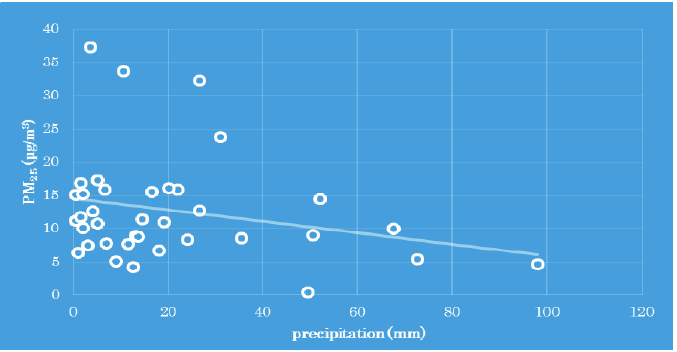
Figure 7. The relationship between PM 2.5 and precipitation during the